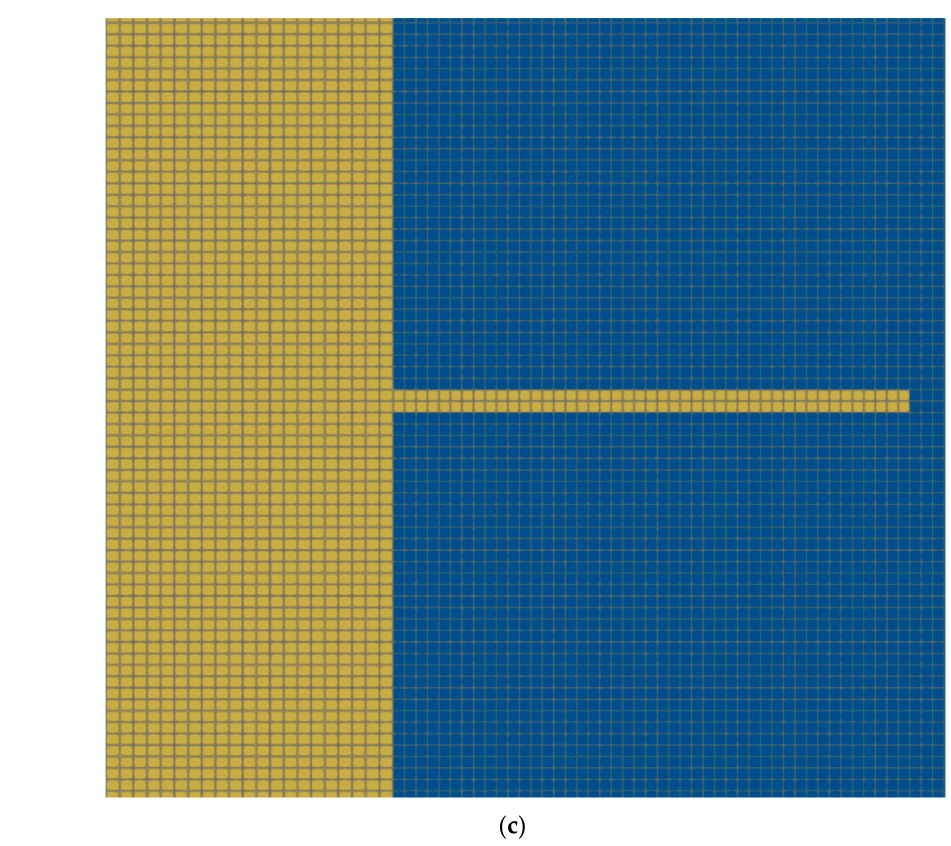
Figure 7. ENACCEF2 facility and computational grid: ( a ) overall scheme, ( b ) obstacle region close-up and ( c ) computational mesh around the obstacle.